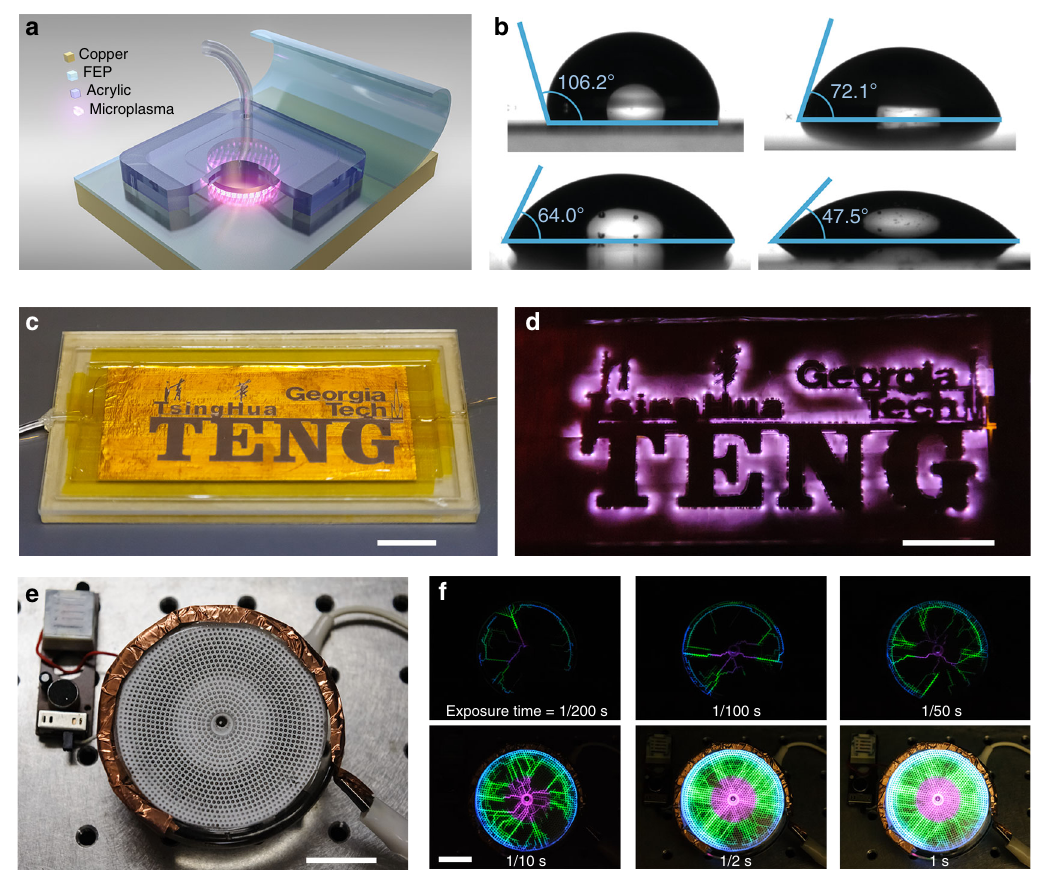
Fig. 5 Applications of triboelectric plasma in surface treatment and luminescence. a , b Contact angle of fl uorinated ethylene propylene (FEP) surface before and after microplasma treatment. a Schematic of surface treatment in use of triboelectric plasma. b Untreated surface, 1 min, 3 min, and 6 min treated by argon plasma, respectively. c , d Example of microplasma luminescence photograph showing patterns of triboelectric nanogenerator (TENG), Tsinghua, and Georgia Tech (scale bar, 20 mm). d No Photoshop (NIKON D700 @ 70 mm, ISO 6400, 30 s, f/2.8). e , f A plasma disk driven by freestanding rotary (FR) TENGs (scale bar, 20 mm). f Photos with different exposure time (NIKON D700 @ 70 mm, ISO 6400,